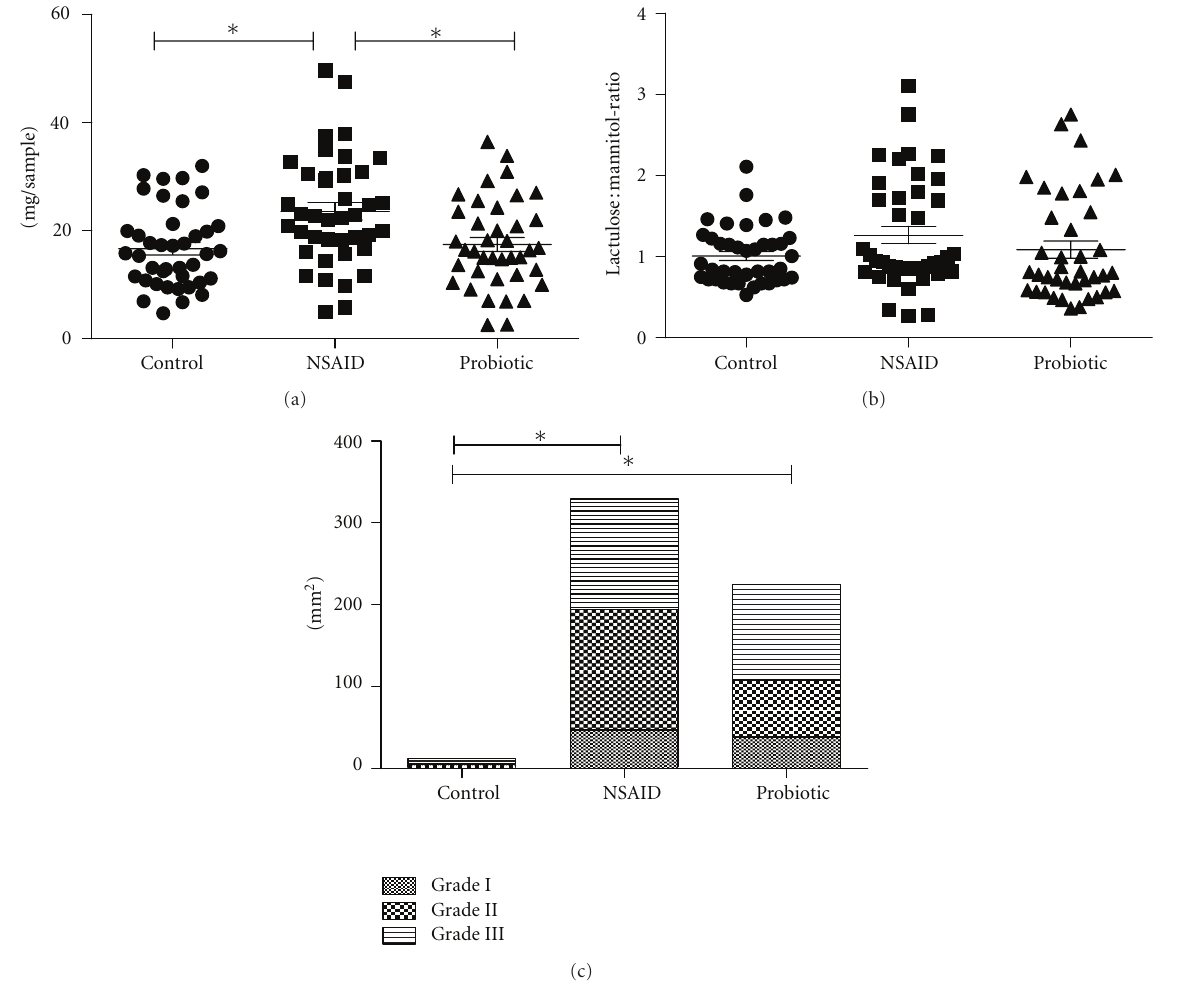
Figure 2: Protective e ff ect of Bifidobacterium lactis 420 against indomethacin-induced side e ff ects. Quantities of permeability probes sucrose (a) and lactulose:mannitol (b) in rat urine samples and the total damage areas (TDA) of gastric mucosa (c) combined from three individual studies ( n = 119). The treatment groups were a control group, an indomethacin-challenged group (NSAID), and a probiotic group supplemented daily with 10 10 colony forming units of Bifidobacterium lactis 420 for seven days prior to indomethacin challenge. Sucrose measures gastric permeability and the lactulose:mannitol-ratio reflects small intestinal permeability. TDA values include Grade I (mild, slight, few, or small), Grade II (moderate appearing, size, or number), and Grade III (severe, massive, or extensive in number or size) lesions. The vertical lines in figures (a) and (b) represent mean values. Significant ( P < 0 . 05) di ff erences between treatment groups are denoted by an